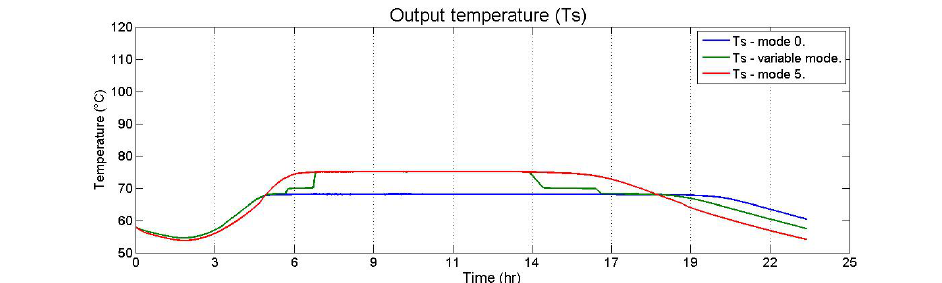
Figure 18. Comparison of the generator temperature of the three modes of operation with a solar radiation of 900 kW/m 2